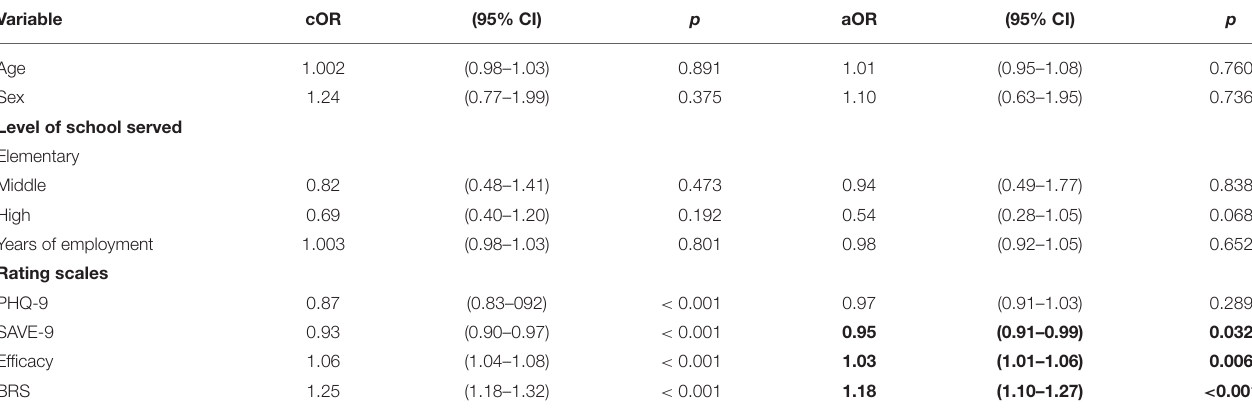
TABLE 4 | Logistic regression analysis for predicting high subjective well-being (WHO-5 top 25%) of teachers during the COVID-19 pandemic.